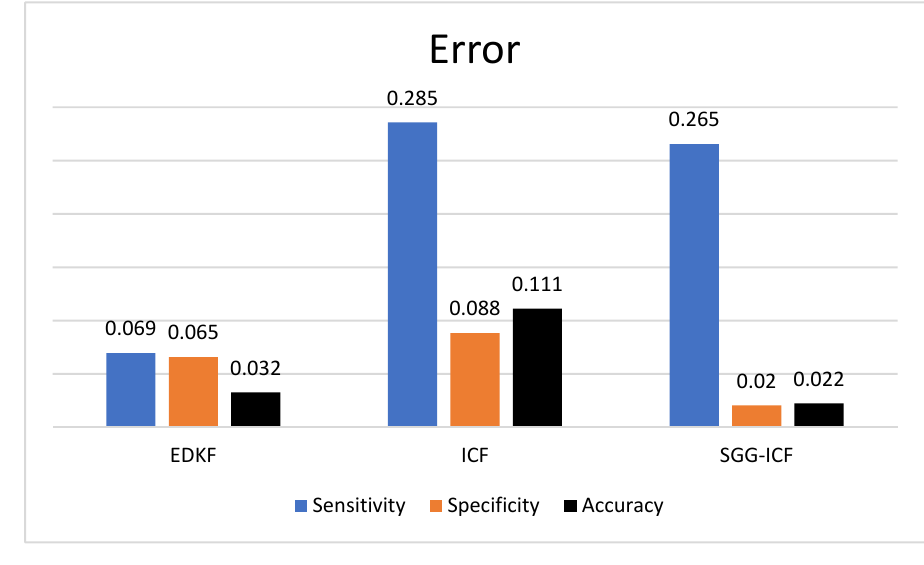
Figure 12. Error categorized by DKF algorithm.